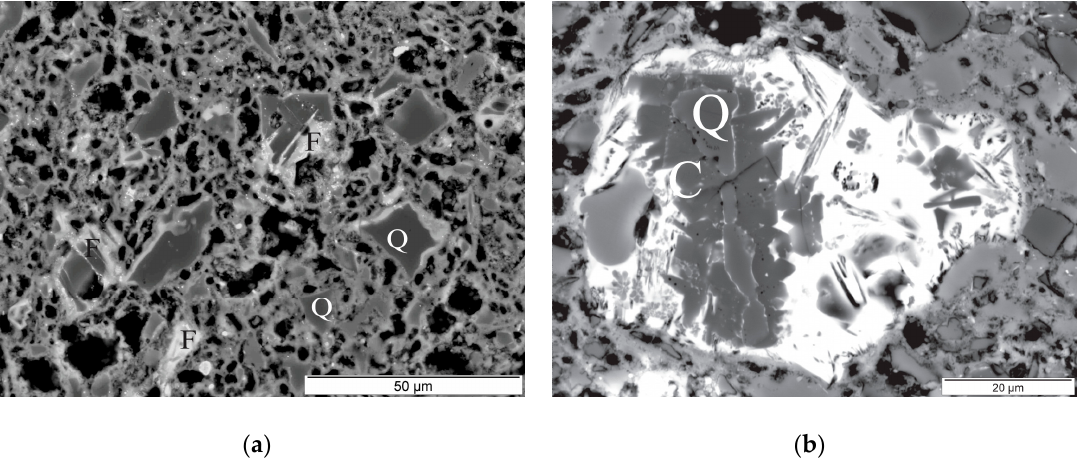
Figure 8. SEM-BSE images. ( a ) CaO-rich broth bowl with handle from Saint-Clément. [16] (An. No. TBL 19) showing angular fragments of quartz (Q), either as isolated grains or embedded in glassy patches (white). The latter case corresponds to a cassiterite-bearing lead alkali frit (F); ( b ) Lead frit with relic quartz (Q) core, surrounded by presumably cristobalite (C) laths in a Pb-rich glass (white). Basal fragment with impressed mark “NIDERVILLER”. [25] (An. No. Nider-1). Three frit types can be defined according to their microstructure and chemical composition: (1)